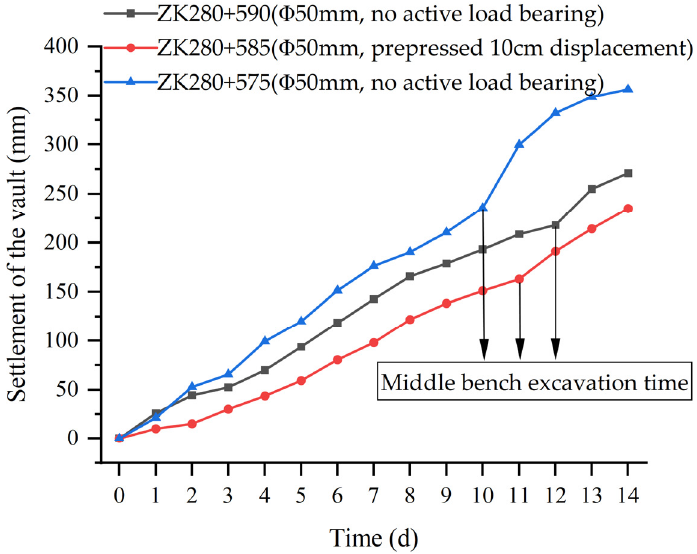
Figure 24. Comparison of measured arch vault settlement curves with and without active bearing.